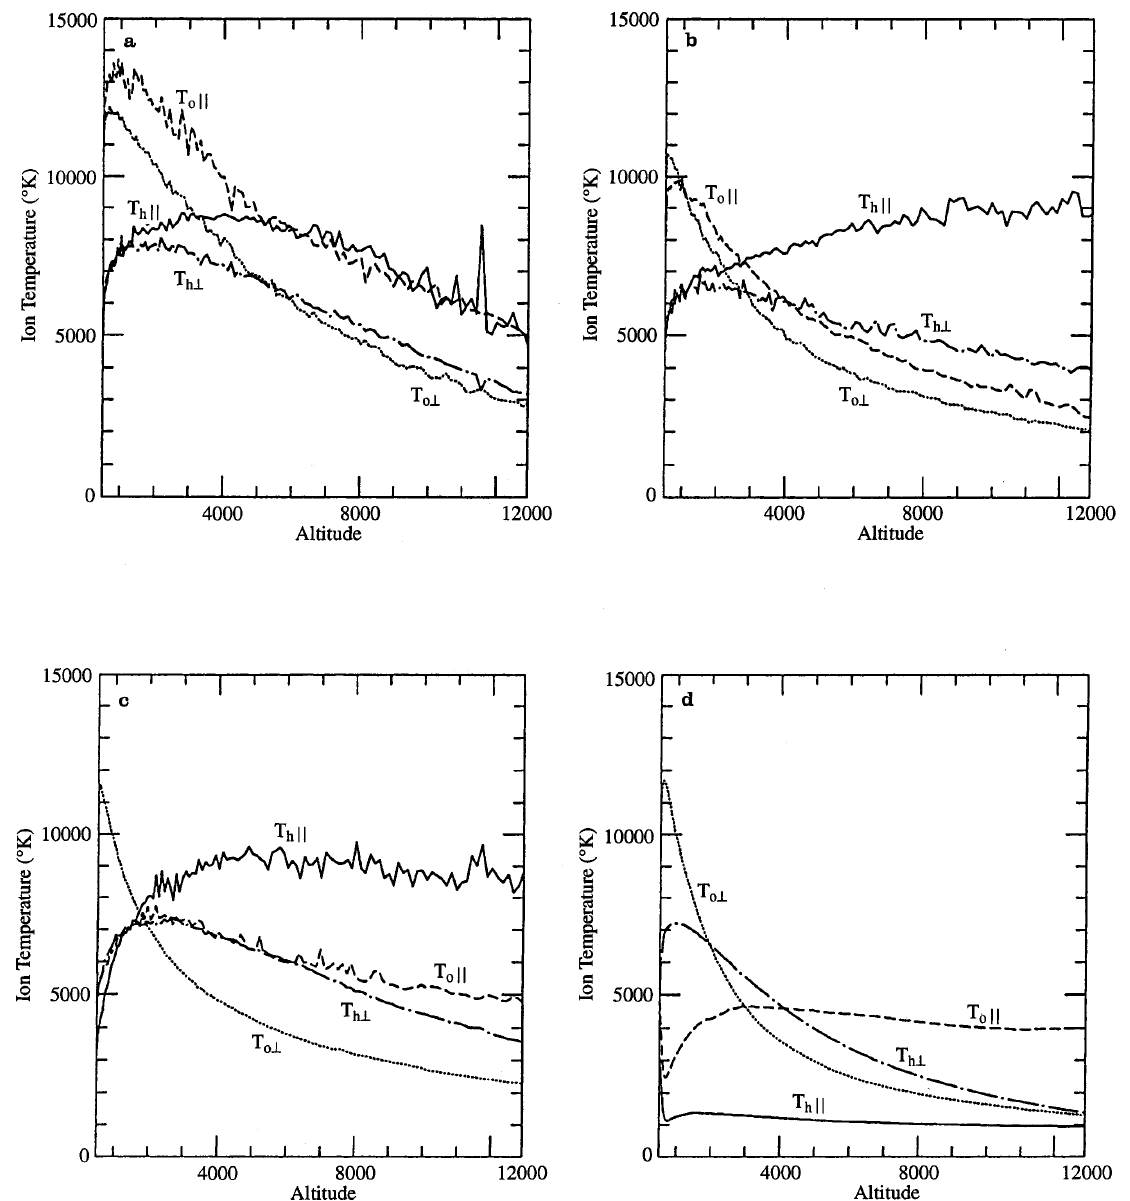
Fig. 21. Profiles of the ion temperatures. The labels correspond to the cases listed in